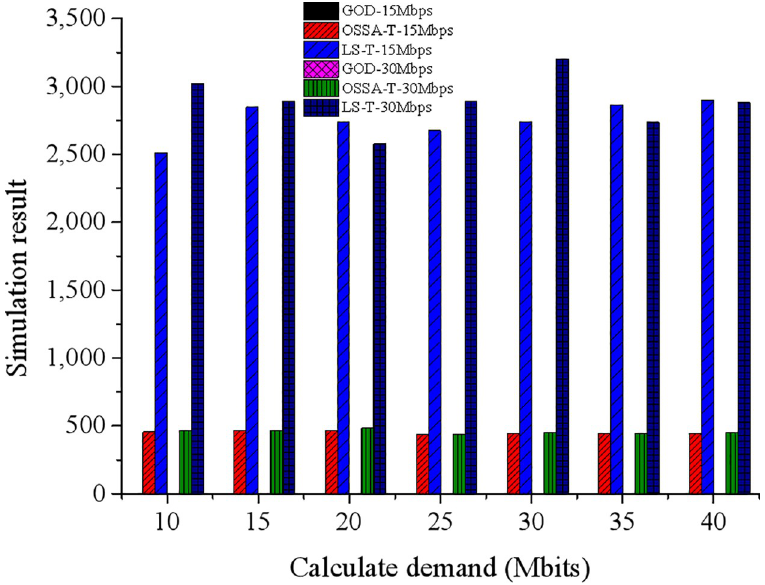
Fig 8. Computing time simulation results of the OSAA and linear search method. GOD, the global optimal time delay; LS, the linear search method; and T, the computing time.